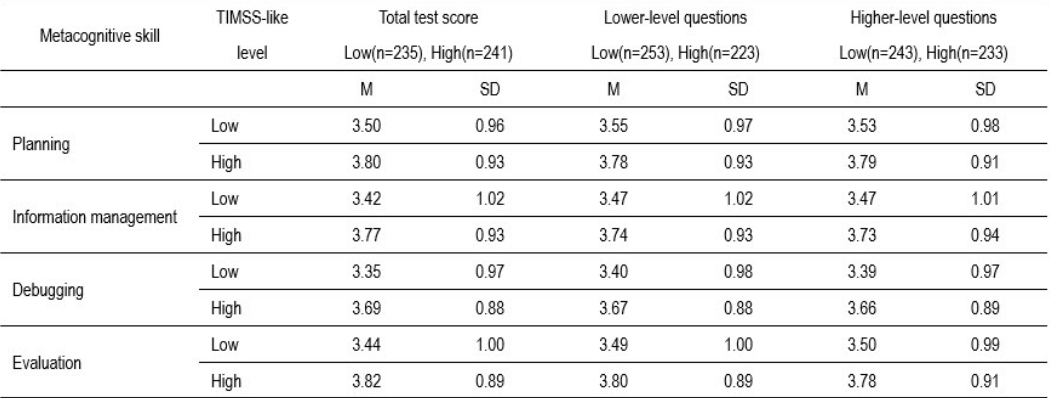
Means and standard deviations of metacognitive awareness perceptions for Grade Five